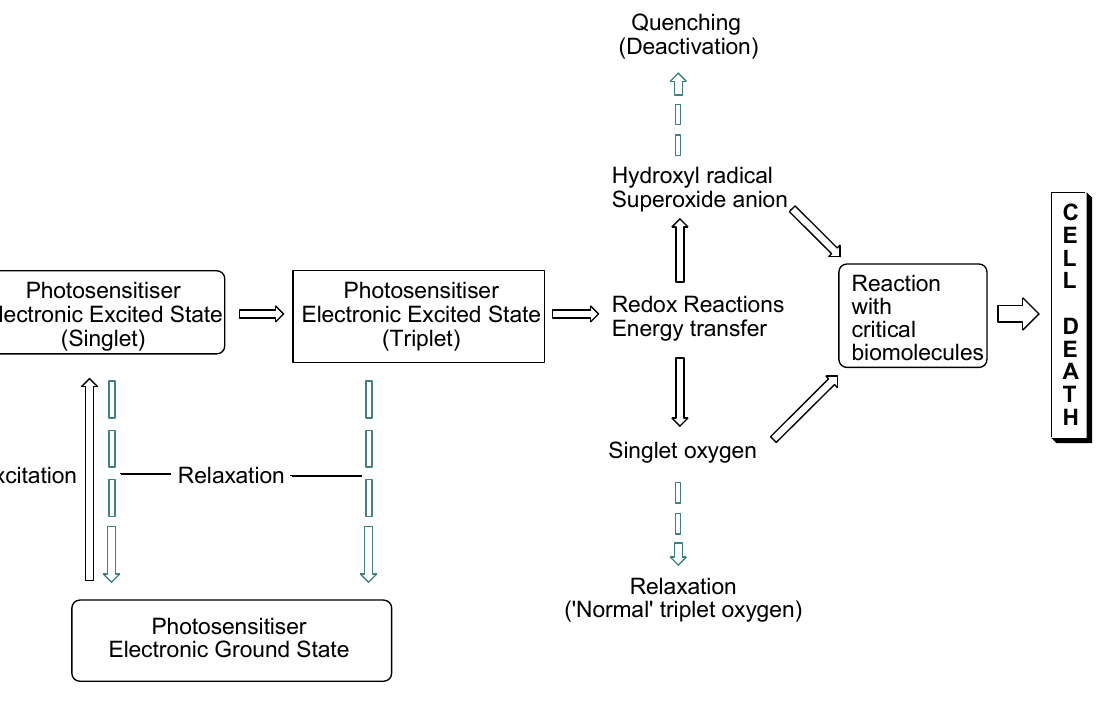
Figure 1. Photosensitisation pathways leading to bacterial cell death. Dashed arrows indicate possible deactivational (non-destructive)